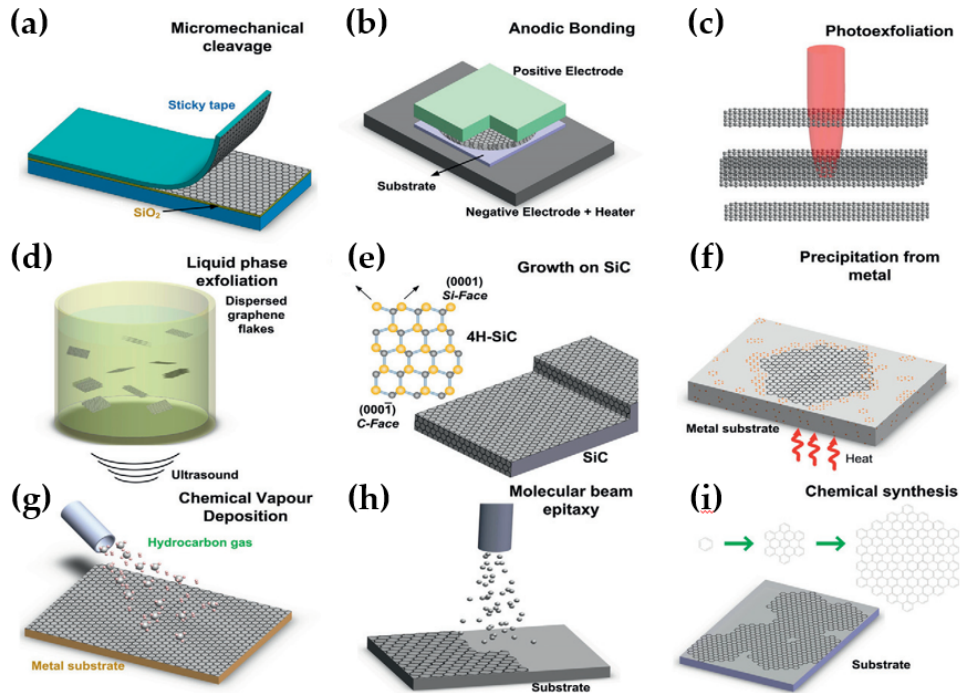
Figure 1. Schematic illustration of the main graphene production techniques. ( a ) Micromechanical cleavage. ( b ) Anodic bonding. ( c ) Photoexfoliation. ( d ) Liquid phase exfoliation. ( e ) Growth on SiC. Gold and grey spheres represent Si and C atoms, respectively. At elevated T, Si atoms evaporate (arrows), leaving a carbon-rich surface that forms graphene sheets. ( f ) Segregation/precipitation from carbon containing metal substrate. ( g ) Chemical vapor deposition. ( h ) Molecular Beam epitaxy. ( i ) Chemical synthesis using benzene as building block (Reproduced with permission from ref. [30]. Copyright 2012 Elsevier Publications).